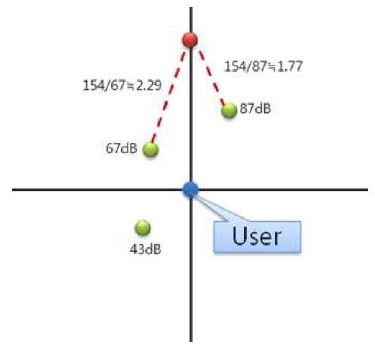
Figure 2. An example of direction estimation based on vector computation .